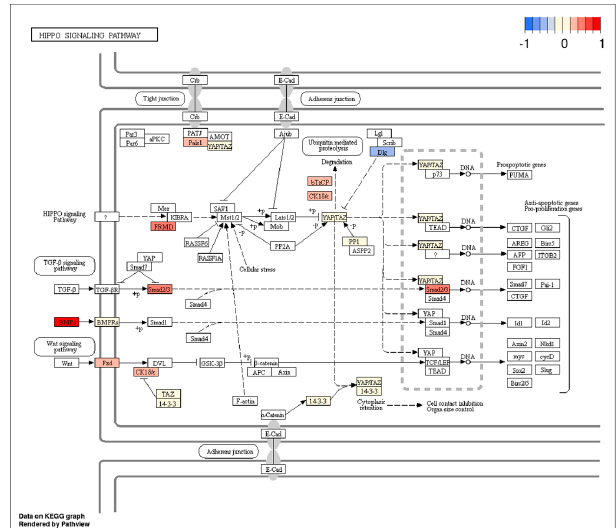
Figure 4. Hippo Signaling pathway with marked expression levels of deregulated genes. Arbitrary signal intensity acquired from microarray analysis is represented by colors (red, higher; blue, lower